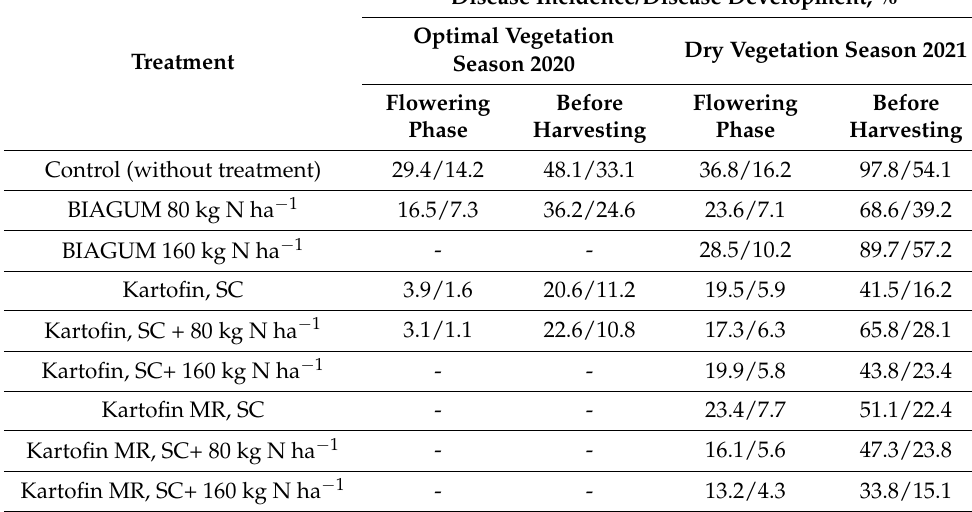
Table 2. The disease incidence and disease development of the dominant fungal diseases com- plex on organic Udacha potato variety under new biorationals’ influence during 2020–2021 vegetation seasons. Disease Incidence/Disease Development, % Optimal Vegetation Treatment Before Flowering Before Phase Harvesting Phase